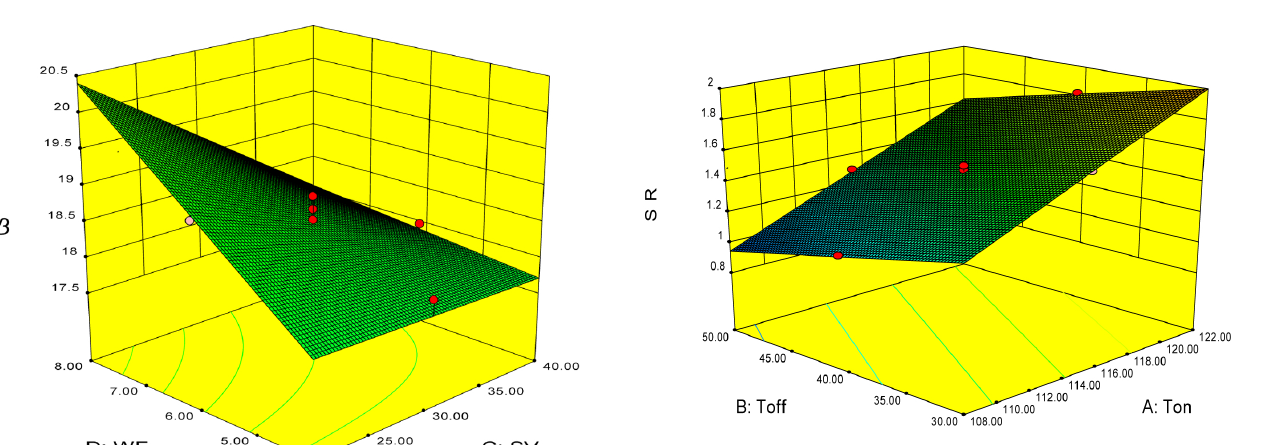
Figure 6c. Combined e ff ects of T on and WF on CS.